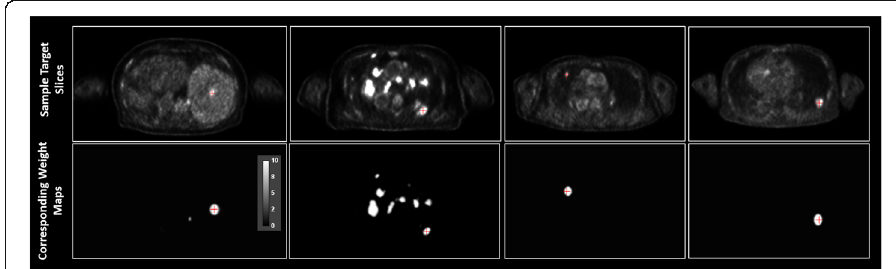
Fig. 3 Sample target slices and corresponding weight maps. Trans-axial slices of sample target images and their corresponding weight maps. The red crosshair marks the same location on both